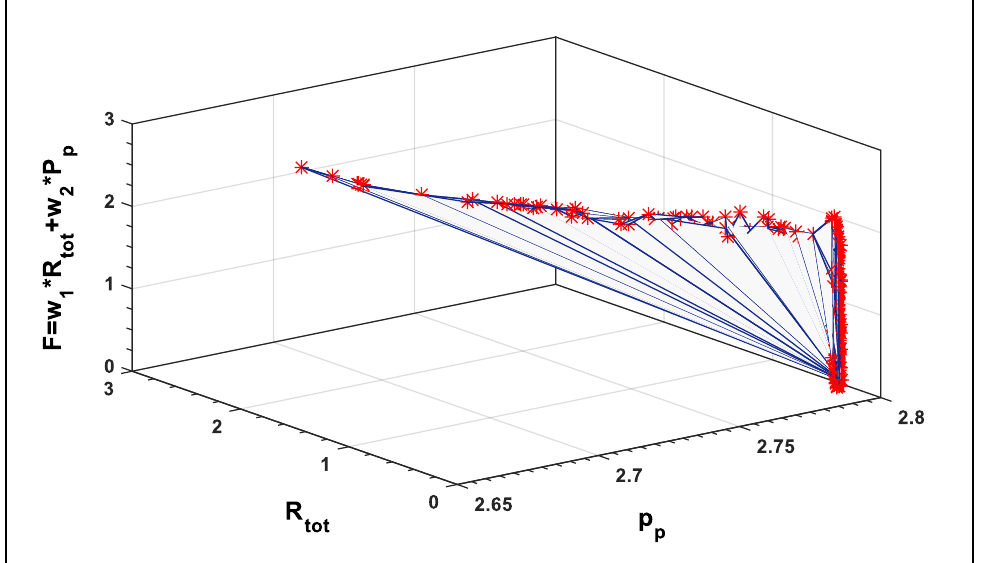
Figure 6. Relation between R tot , P p , and